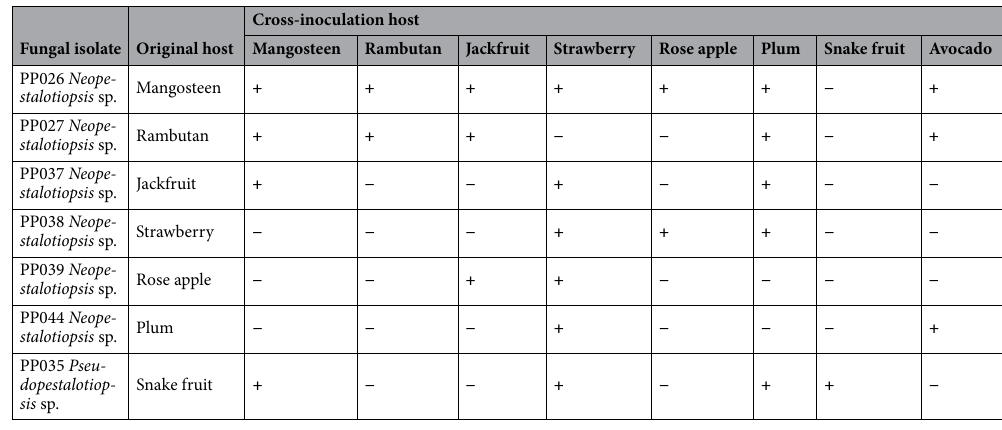
Table 2. Pathogenicity and cross-inoculation of Neopestalotiopsis and Pseudopestalotiopsis isolates on different tropical fruit hosts. + Observed symptoms. − No symptoms.